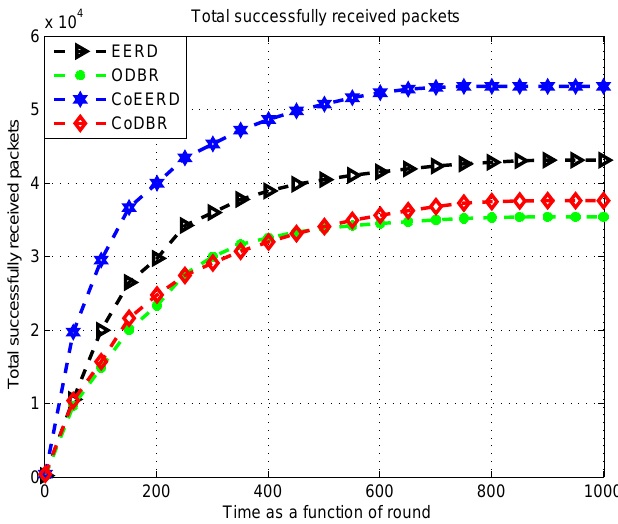
Figure 13. Total Packets Received at Sink